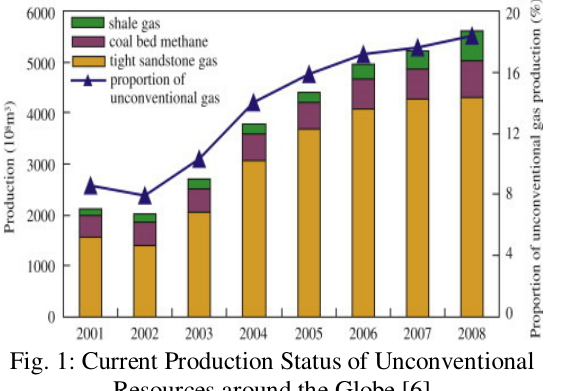
Fig. 1: Current Production Status of Unconventional